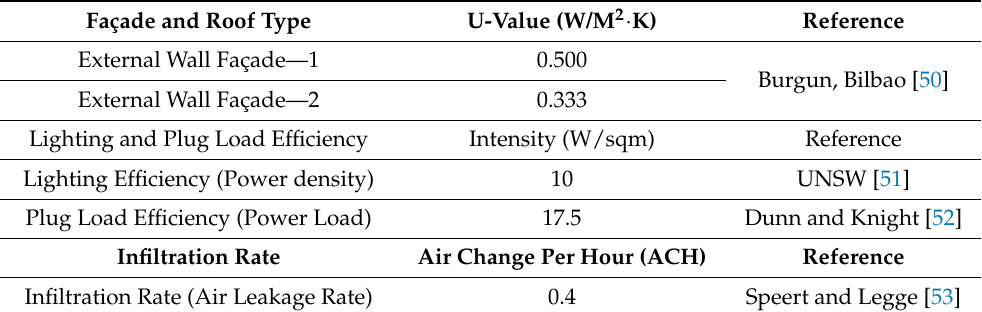
Table 15. Material properties chosen for validation